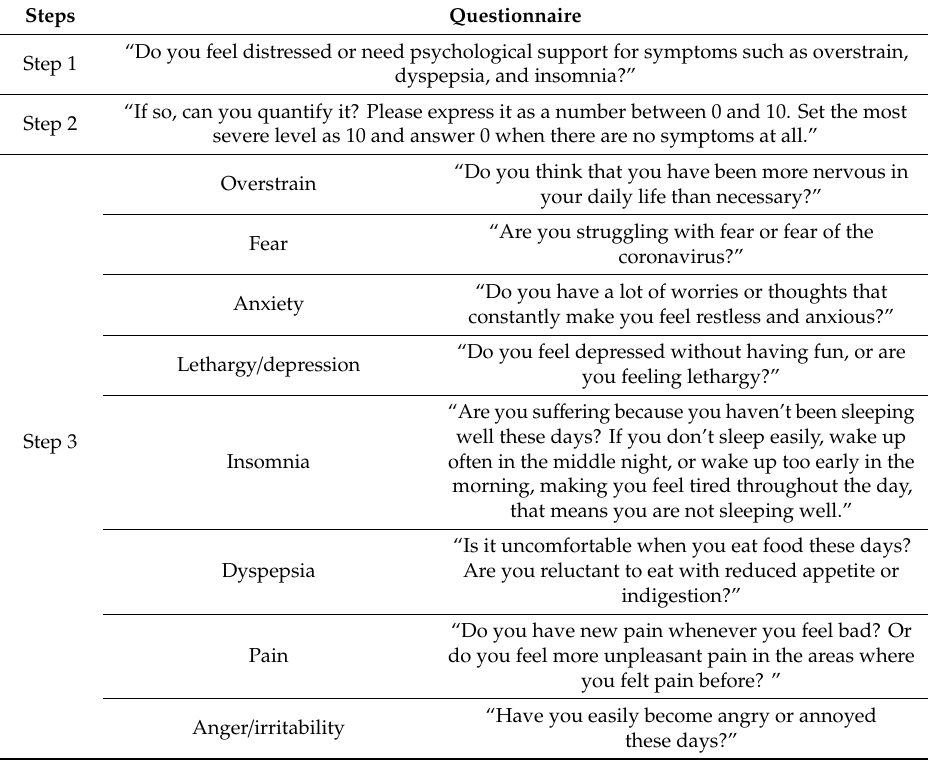
Table 1. History taking: 3-step approach.